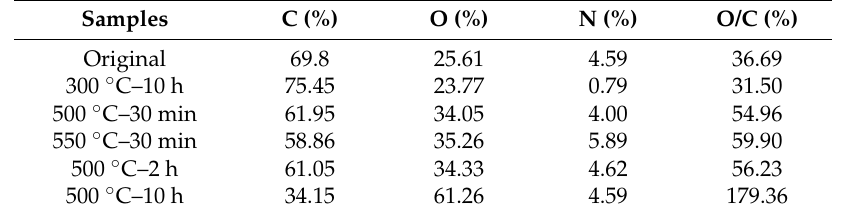
Table 4. Surface element contents of original and exposed carbon fibers determined by XPS.